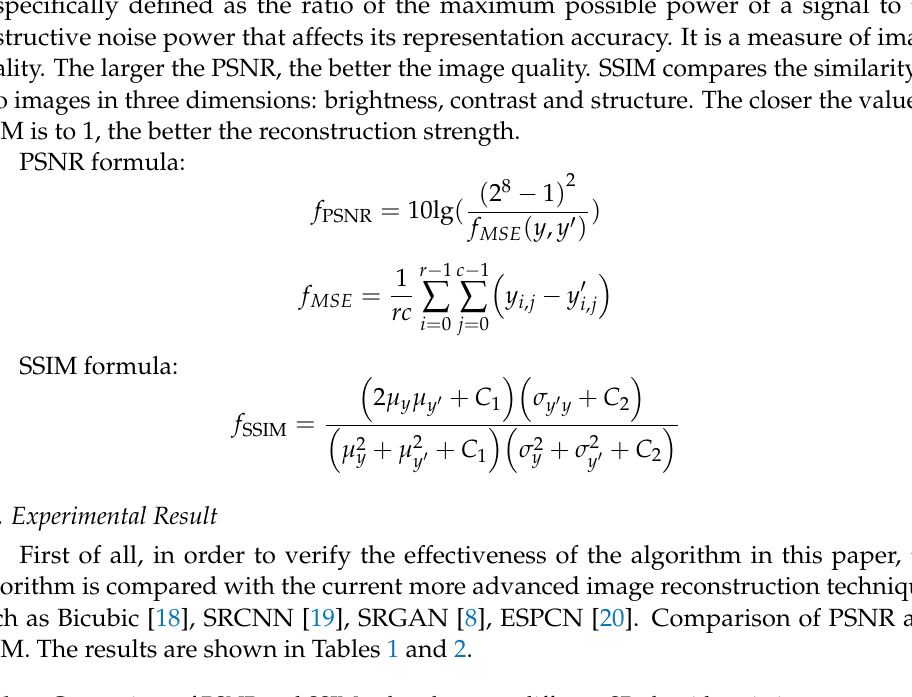
Table 1. Comparison of PSNR and SSIM values between different SR algorithms in image reconstruc- tion.